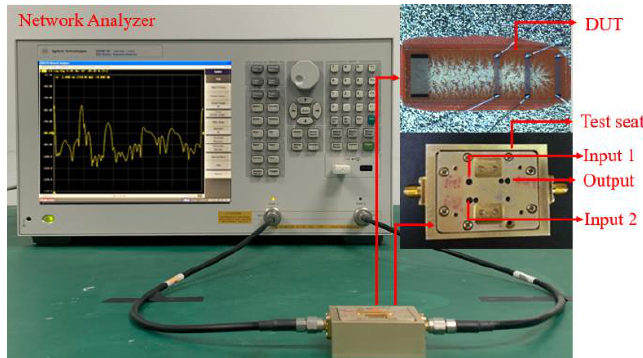
Figure 5. The experimental setup for characterizing the proposed SAW sensing devices.